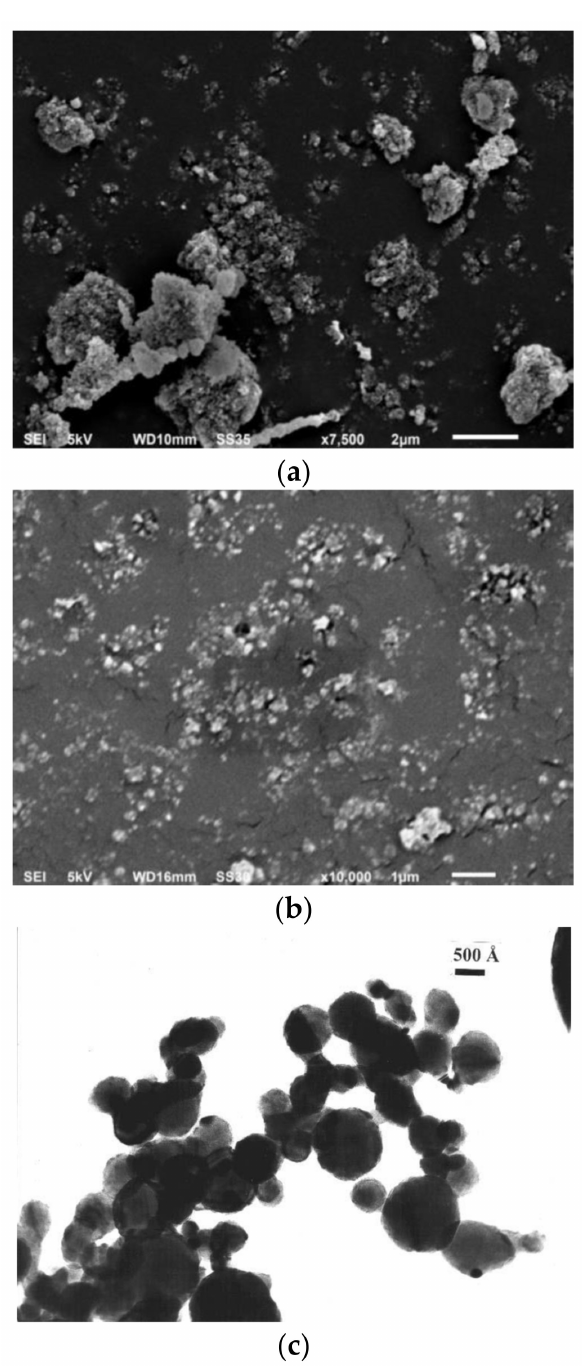
Figure 4. SEM images of nanoparticles tested: ( a ) water–Al 2 O 3 , ( b ) water–TiO 2 , ( c )